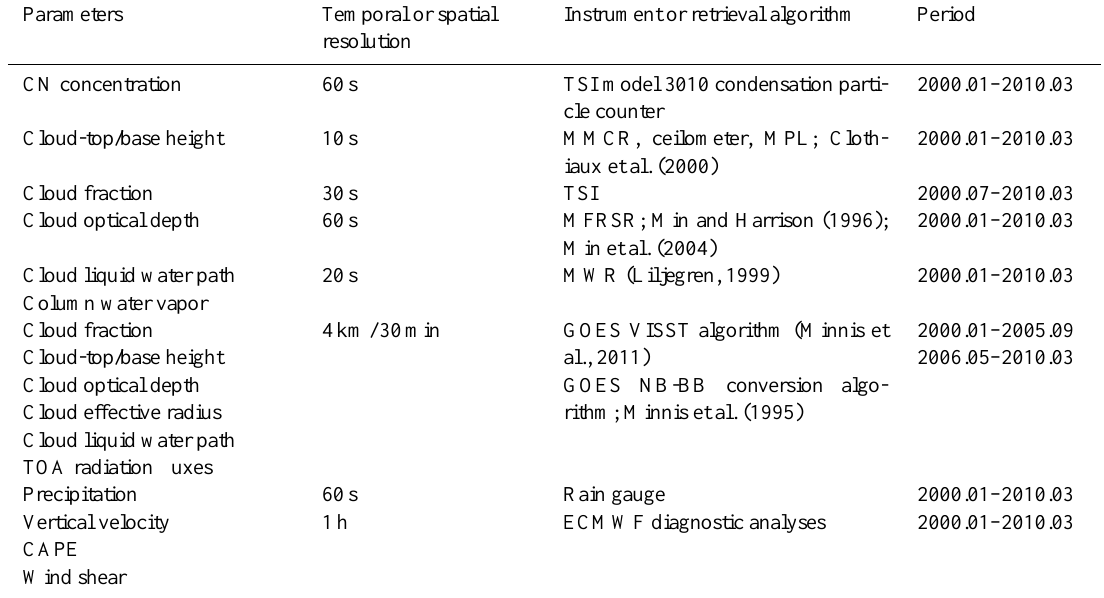
Table 1. Data sets used in the